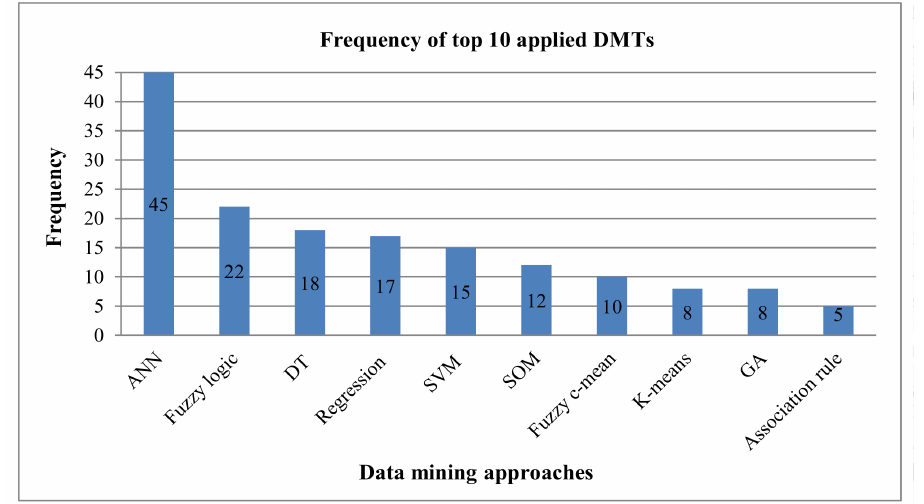
Figure 7. The frequency of the top 10 applied